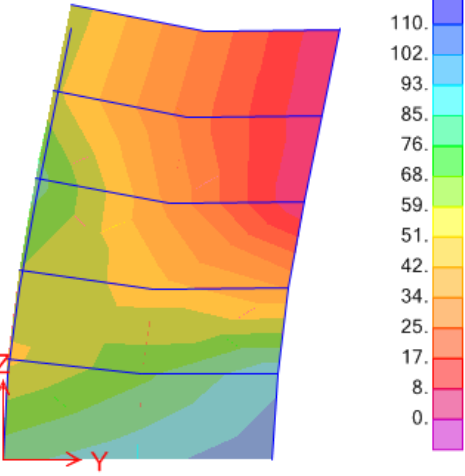
Fig. 12. Ultimate level of shear stress distribution for one pier Figure 12. Ultimate level of shear stress distribution for one pier element of TD-83/3 building obtained element of TD-83/3 building obtained from pushover analysis (y- direction – from pushover analysis (y- direction - kPa) Figure 11. Ultimate level of shear stress distribution for one wall element of TD-83/3 building obtained Fig. 11. Ultimate level of shear stress distribution for one wall el- ement of TD-83/3 building obtained from pushover analysis (x- from pushover analysis (x- direction - kPa) direction – kPa).